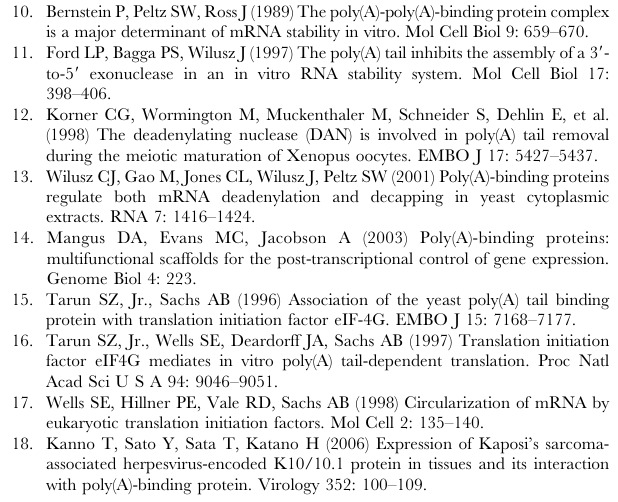
Figure S5 Replacing the poly(A) signal of PAN RNA with a U7 snRNP-dependent 3 9 -end formation signal (PAN RNA D -poly(A) tail) [6] reduces the effect of SOX co-transfection on PAN accumulation in 293T cells, as viewed by confocal microscopy. Note that some cells in which PABPC1 appears nuclear show slightly enhanced signal even for PAN RNA lacking a poly(A) tail, as indicated with white arrows, consistent with the northern blot results (see Fig. 2A). Figure S6 qRT-PCR analysis of GAPDH mRNA in total RNA extracted from BCBL1 TReX-RTA cells that were electroporated with the indicated modified oligonucleotides and induced with doxycycline for the indicated times. Figure S7 Immunoblots probed with anti-RTA, anti-vIL-6 and anti-K8.1 antibodies, from 9 independent knockdown experi- ments. Blots were developed either with a G:BOX (Syngene) (panels A, B, C and E) or by x-ray film (panels D, F, G, H and I). For the former, densitometry analysis was performed with GeneTools software (Syngene), ensuring use of non-saturated signal. Furthermore, linearity of signal was confirmed by titration of lysate. For data collected with x-ray film, a titration of exposure time was performed for each blot to avoid analysis of x-ray film that had been overexposed. X-ray films were then scanned and densitometry was performed using Image J software (NIH).